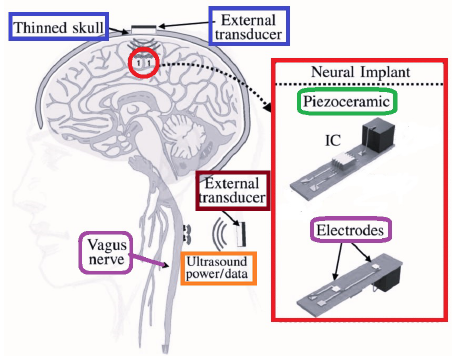
presented in Figure 29. That neural implant includes piezoelectric receiver, sub-mm IC and recording electrodes where the total area is only 2.7 mm 3 . The effectiveness of this device was verified through implementation in rats.